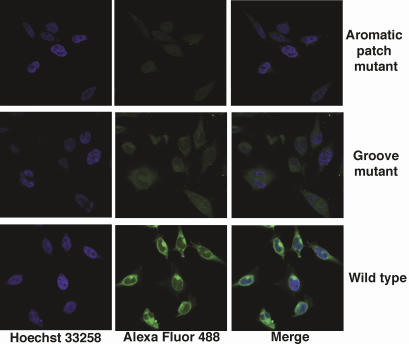
Binding of Mutant CDT- Alexa Fluor 488 Holotoxin to CellsHeLa cells were treated for 2 hr with 5 μg/ml concentration of wild-type or mutant fluorescently labeled holotoxin in 3% BSA/PBS at 37 °C, 5% CO2. Samples were co-stained with Hoechst 33258 dye to visualized nuclei. Toxin was washed out, and cells were fixed in 3.7% formaldehyde and mounted with ProLong Gold Antifade Reagent (Molecular Probes). Confocal images were taken under an inverted LSM510 confocal microscope (Zeiss) using ×60 objective lenses. The aromatic patch mutant contains wild-type CdtB and CdtC, and mutant CdtA (W91G/W98G/W100G/Y102A); the groove mutant contains wild-type CdtB and mutant CdtA (P103A/Y106A), and CdtC (R43K/Q49A).